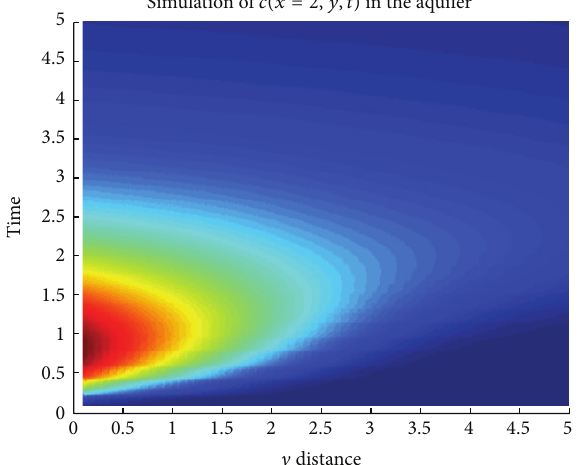
Figure 6: Contour plot of the approximate solution in y -direction for fixed 𝑥 .